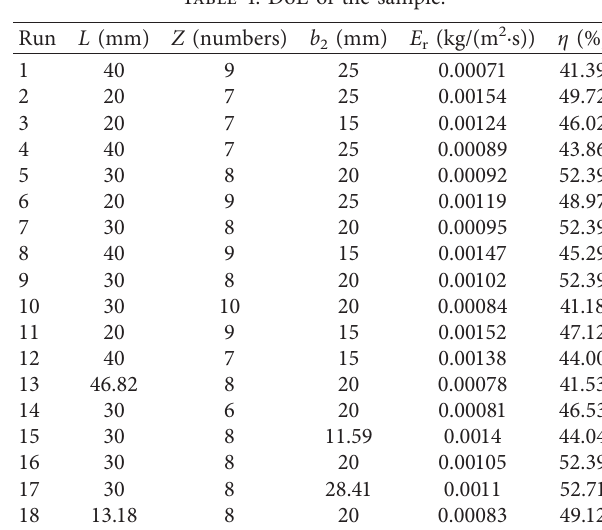
Table 4: DoE of the